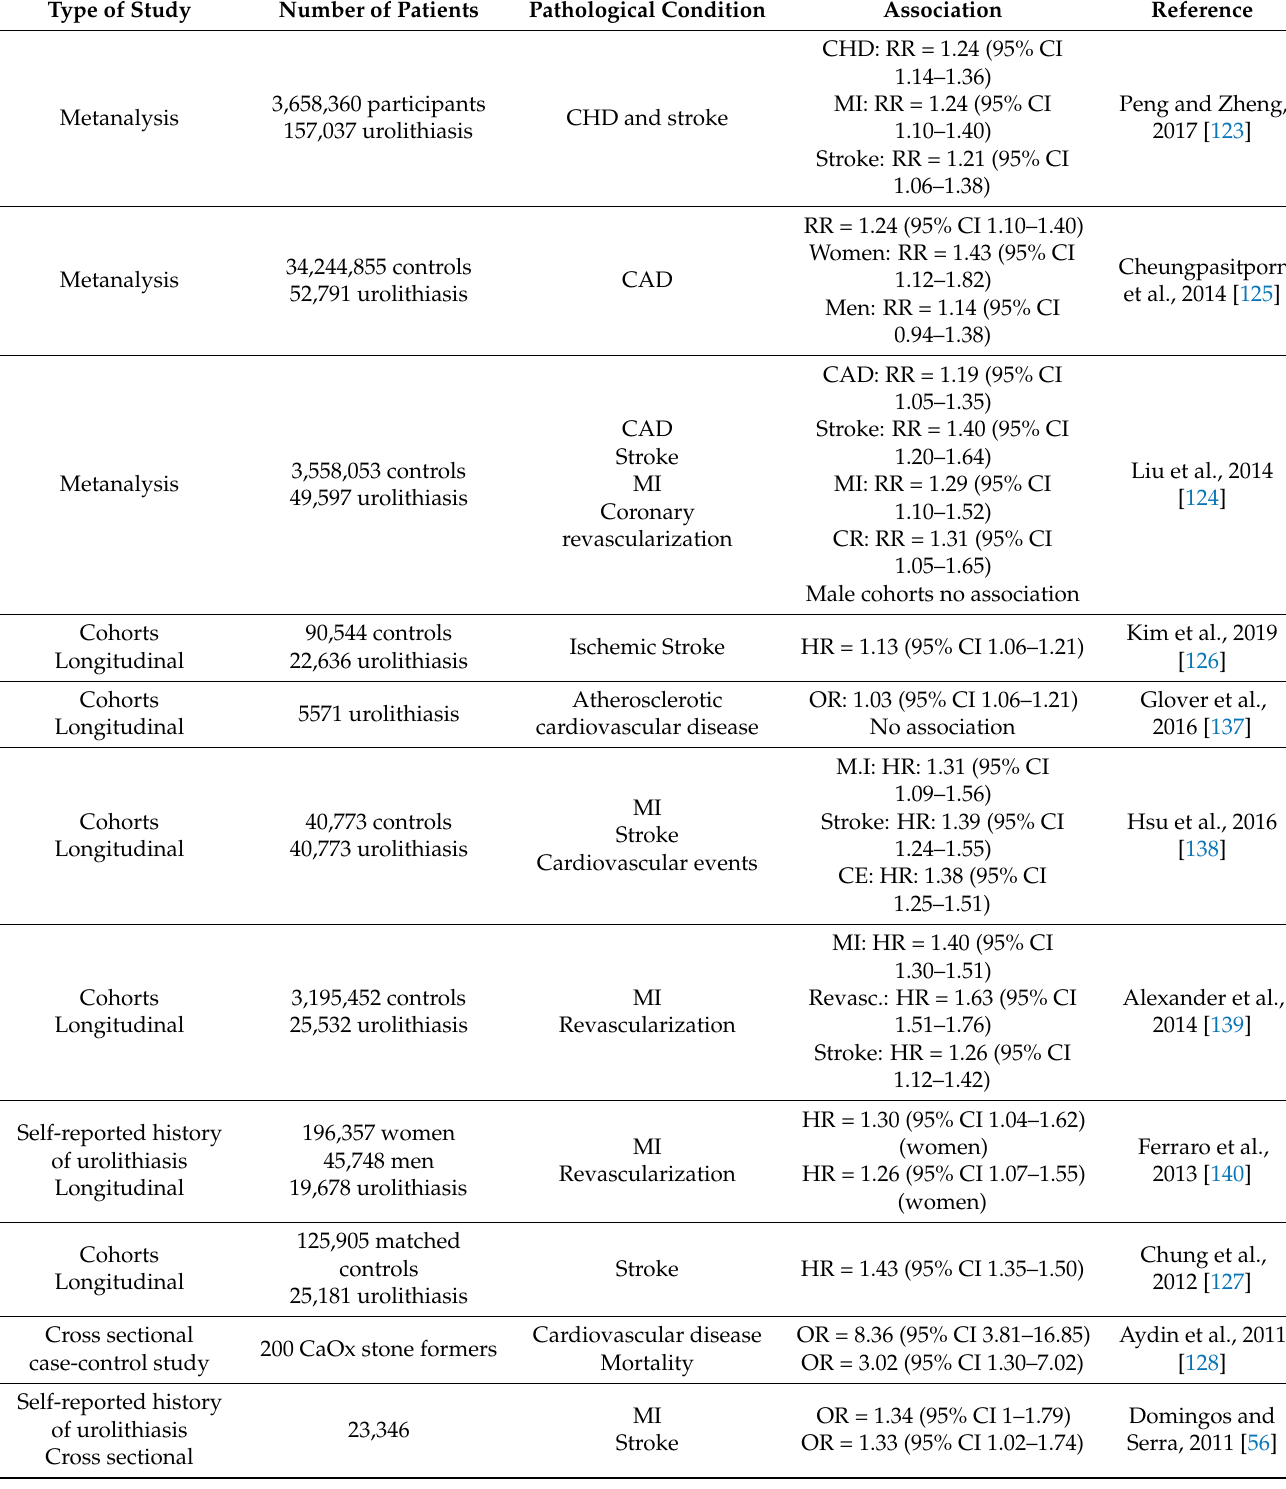
Table 1. Characteristics of metanalysis and clinical studies in which association between urolithiasis and cardiovascular morbidity has been studied. CHD: Coronary heart disease. CAD: Coronary artery disease. MI: Myocardial